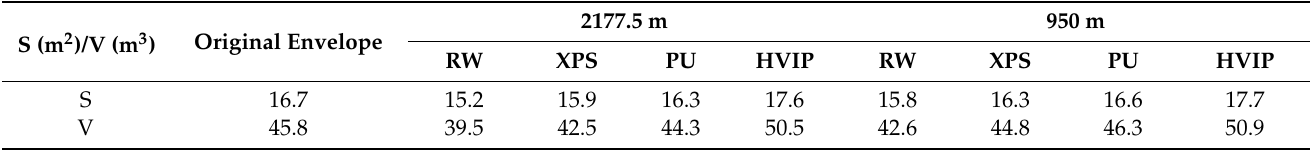
Table 7. Usable area (S) and usable volume (V) under the NZEB